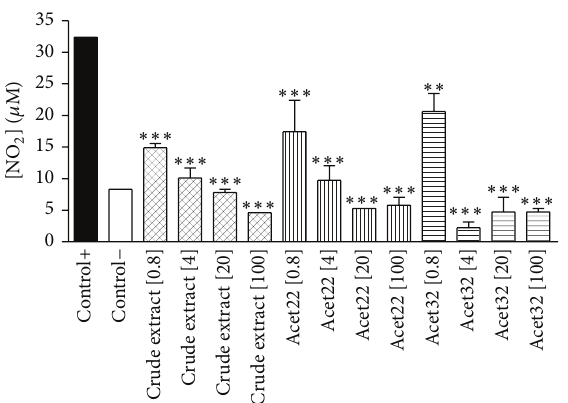
Figure 7: The inhibitory effect on NO production by crude extract and flavonoids Acet22 (isoquercitrin) and Acet32 (afzelin) at concentrations of 0.8, 4, 20, and 100 𝜇 g/mL in lipopolysaccharide- (LPS-) stimulated RAW 264.7 macrophages. Negative control: macrophages without stimuli. Positive control: macrophages stim- ulated with 1 𝜇 g/mL LPS. Treatment with L-NMMA was used also as a positive control of NO inhibition, reducing NO production by 59.22±2.96 % at 20 𝜇 g/mL. ∗ 𝑃 < 0.05 , ∗∗ 𝑃 < 0.01 , and ∗∗∗ 𝑃 < 0.001 , significance obtained by ANOVA and posttest Tukey ( 𝑛 = 3 ) when compared to the positive